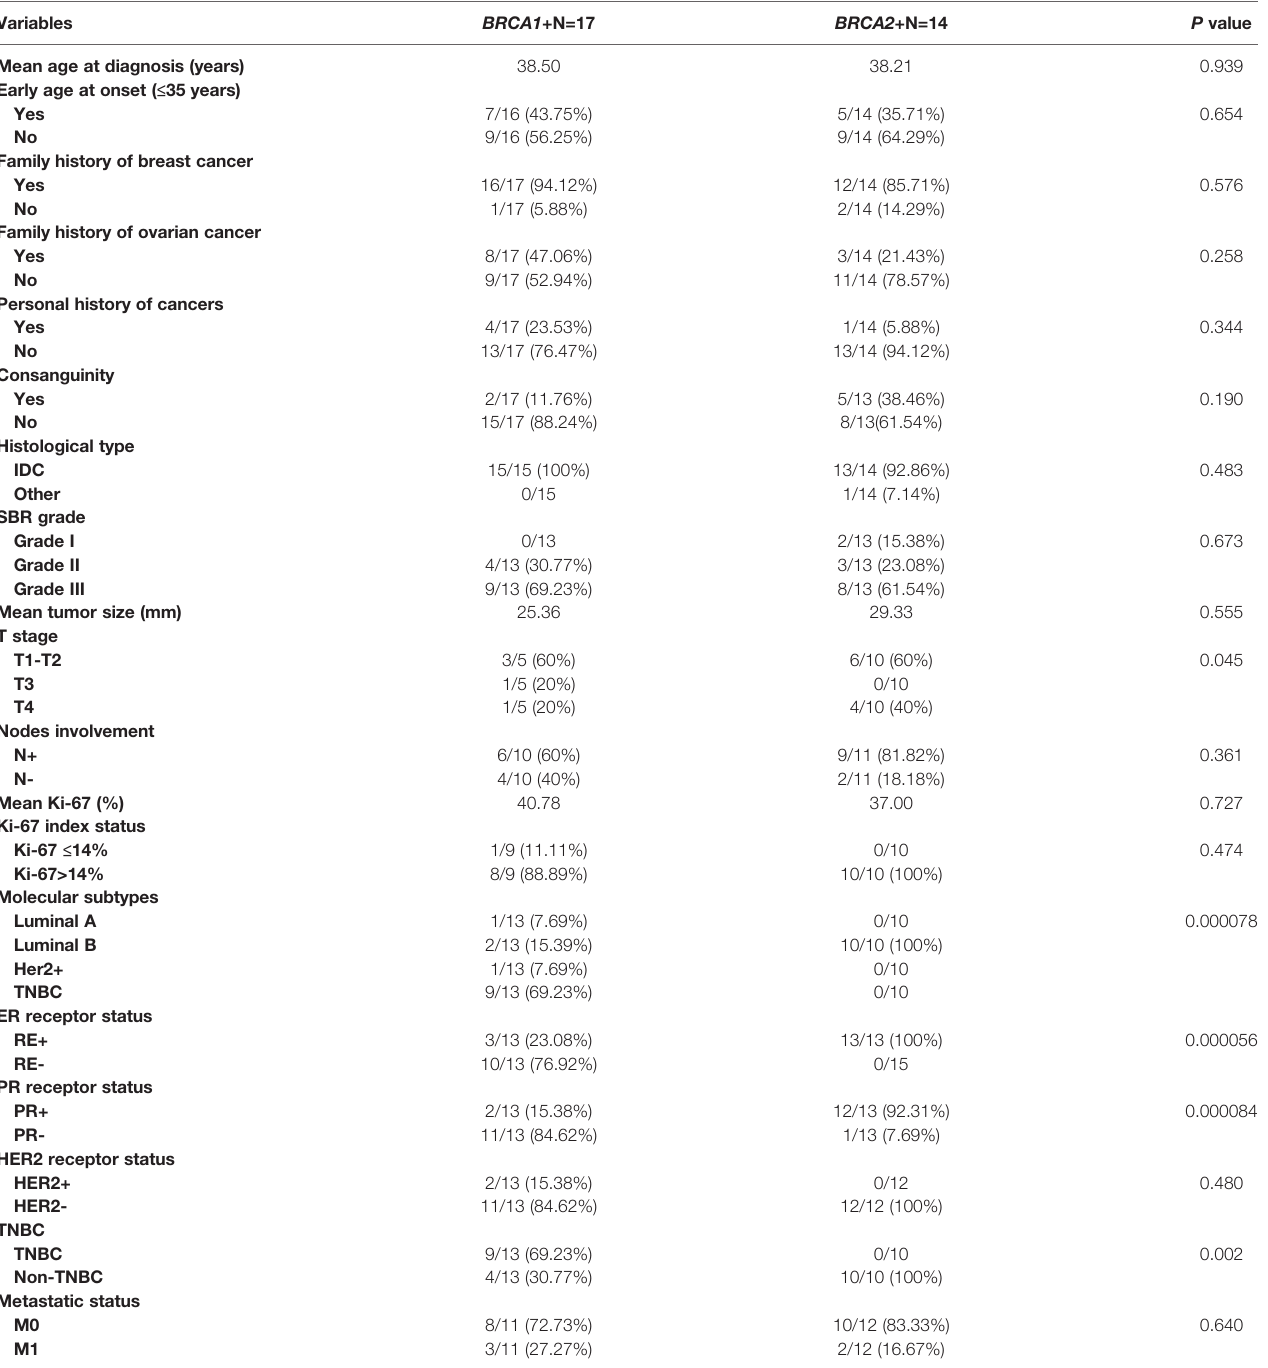
TABLE 5 | Epidemiological and clinico-pathological characteristics of patients carrying BRCA1 and BRCA2 mutations. Variables BRCA1+ N=17 BRCA2+ N=14 P value Mean age at diagnosis (years)